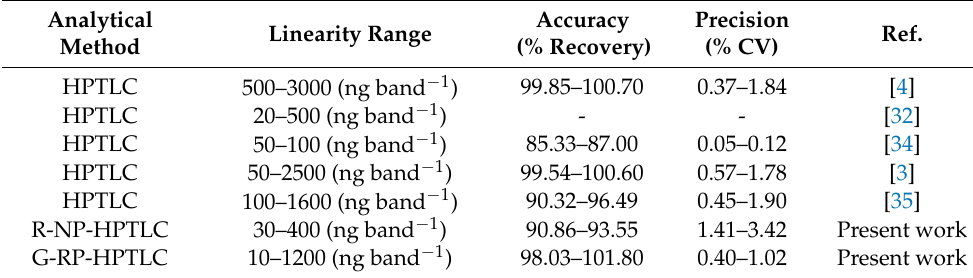
Table 6. Comparison of present R-NP-HPTLC and G-RP-HPTLC assays with literature HPTLC assays for the quantitation of TRV.